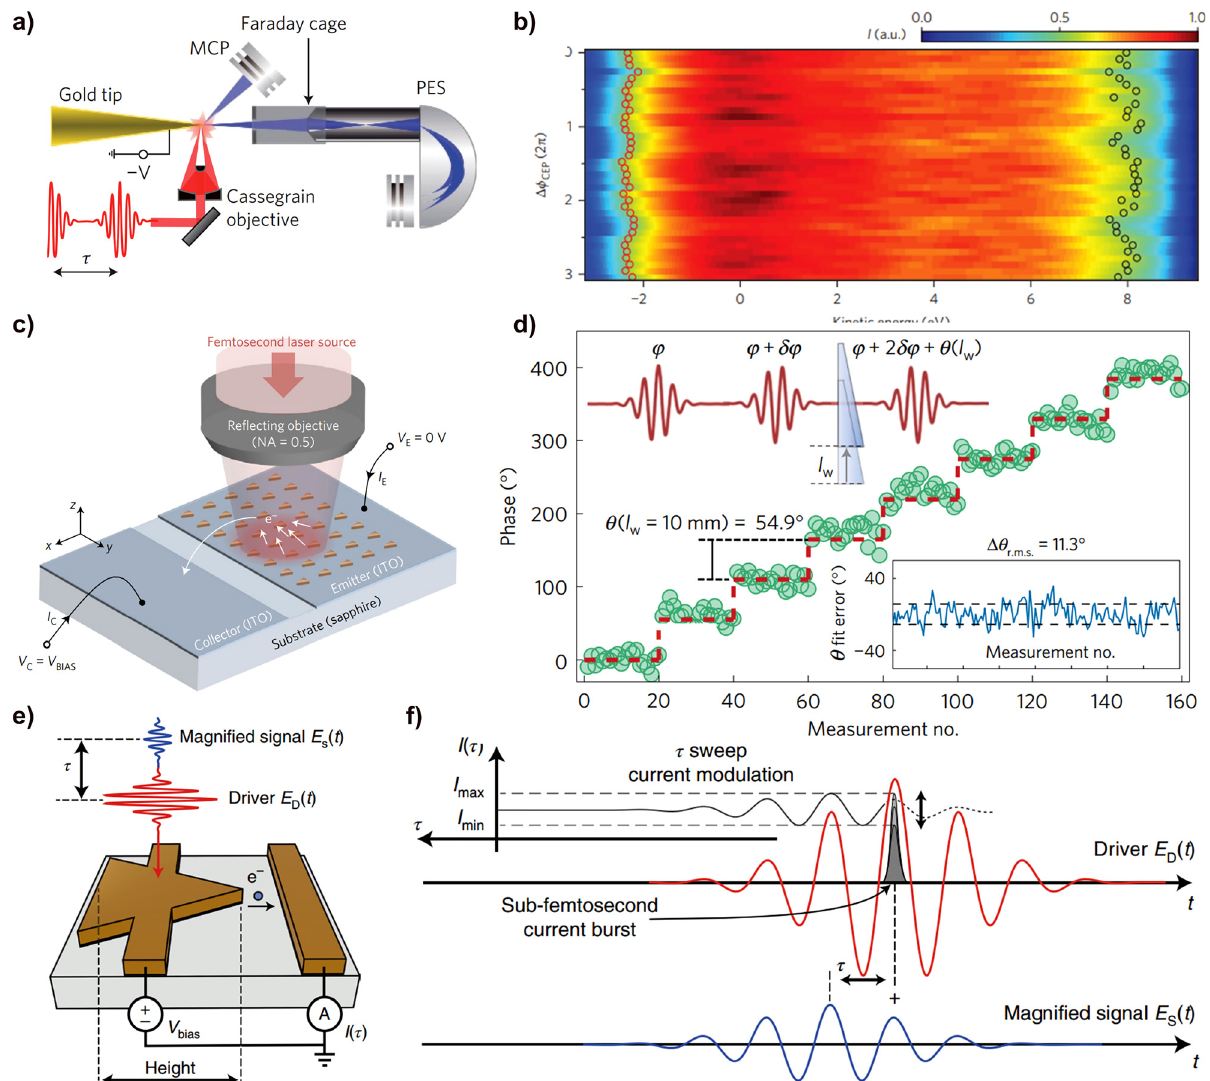
Figure 15: CEP and light-wave dependent photoelectron emission in a plasmonic nanotip under the strong-field condition. (a) Photoelectron emissionmeasurementwith a CEP-stabilized few-cycle pulse.The Au tip is electricallybiased to modifyitspotentialbarrier. Photoelectron yields and kinetic energy are measured with a microchannel plate (MCP) and photoelectron spectrometer (PES), respectively. (b) The CEP-dependent electron kinetic energy spectra under strong field conditions. Red and black circles indicate the low and high energy cut-off, respectively [195]. (c) Schematic of a nanostructure-based optoelectronic device for phase-sensitive photoelectron emission measurement.Thedevicecomprisesacollectorandemitterregionwitha5 μ mgap.TheAunanostructurearrayisfabricatedontheindium-tin- oxide (ITO) emitter region. The SP effect and external bias allow the device to measure the emitted photoelectron from the nanostructures in ambient conditions. (d) CEP-dependent phase measurement from the device under strong fi eld conditions. The CEP changes by inserting an optical wedge and are measured using the lock-in current detection method. The right inset shows the stability of the measured signal [196]. (e) Schematic of the subcycle fi eld sampling device. The device comprises an Au antenna and nanowire with a 50 nm gap. The emitted photoelectrons in the Au antenna are collected by the Au nanowire, which results in the photocurrent with a lock-in detection method. (f) The schematic of the optical fi eld sampling process. A strong driving fi eld generates a photoelectron with a sub-femtosecond current burst (gray pulse); the photoelectron yields are modulated by the weak fi eld (blue line), which allows the waveform reconstruction